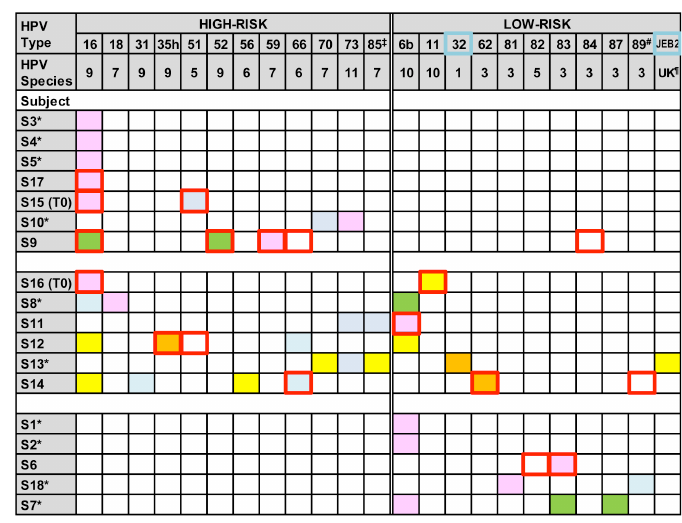
Figure 3. HPV genotyping by deep sequencing/HPV-QUEST. Each HPV genotype captured by deep sequencing within an individual is depicted as a color-filled block: Pink represents HPV type defined by ≥95% of sequences; orange, sequences ≥50% but <95%; yellow, sequences ≥1% but <50%; green, sequences ≥0.1% but <1%; and blue, <0.1% sequences. Red-outlined squares represent HPV types detected by LA. All HPV types, except for HPV32 and JEB2 outlined by blue, are covered by LA probe set. Symbols: *, sample untyped by LA; ‡, HPVcand85; #, HPVcand89; ¶, unknown. Reference sequences for genotypes identified in the study samples include: HPV16 (GI|333031), HPV18 (GI|60975), HPV31 (GI|333048), HPV35h (GI|396997), HPV51 (GI|333087), HPV52